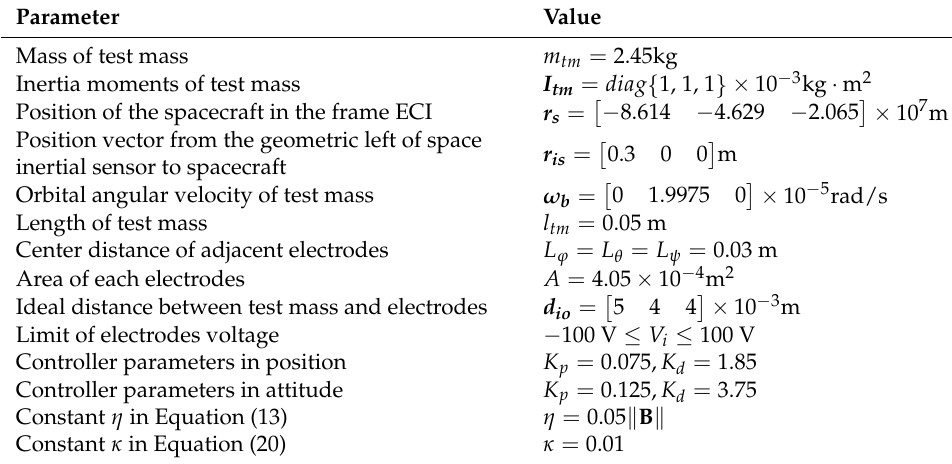
Table 2. The parameters of the numerical